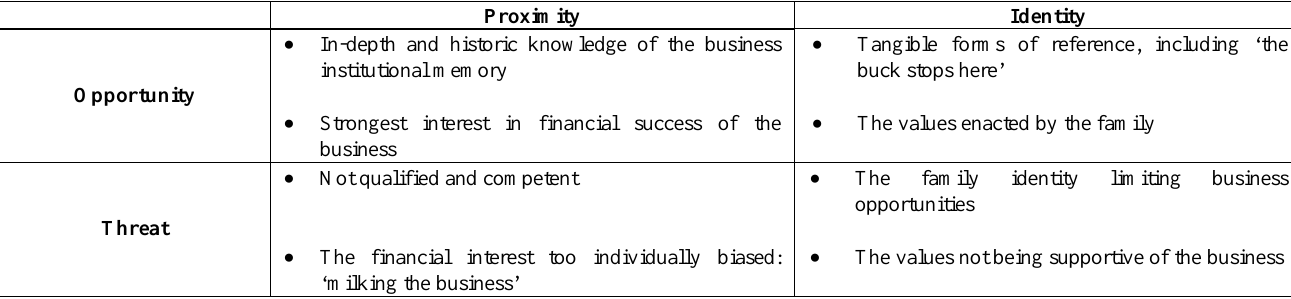
Table 2: Opportunities and threats created by the owning family in family